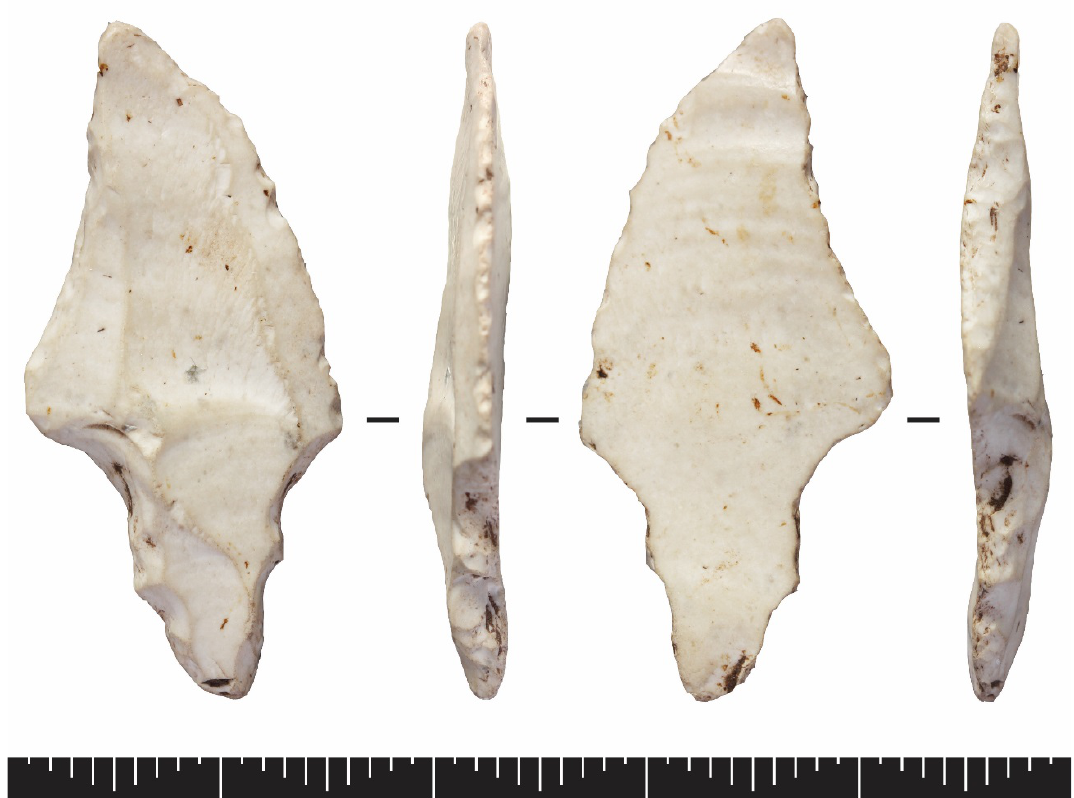
Figure 4. The small tanged point from 2010 test-pit (10,10) at RPAS. Largest dimensions are length: 31.9 mm, width: 14.5 mm, thickness: 3.7 mm, weight: 1.2g, noting that these are of an abraded artefact (scale bar: cm and